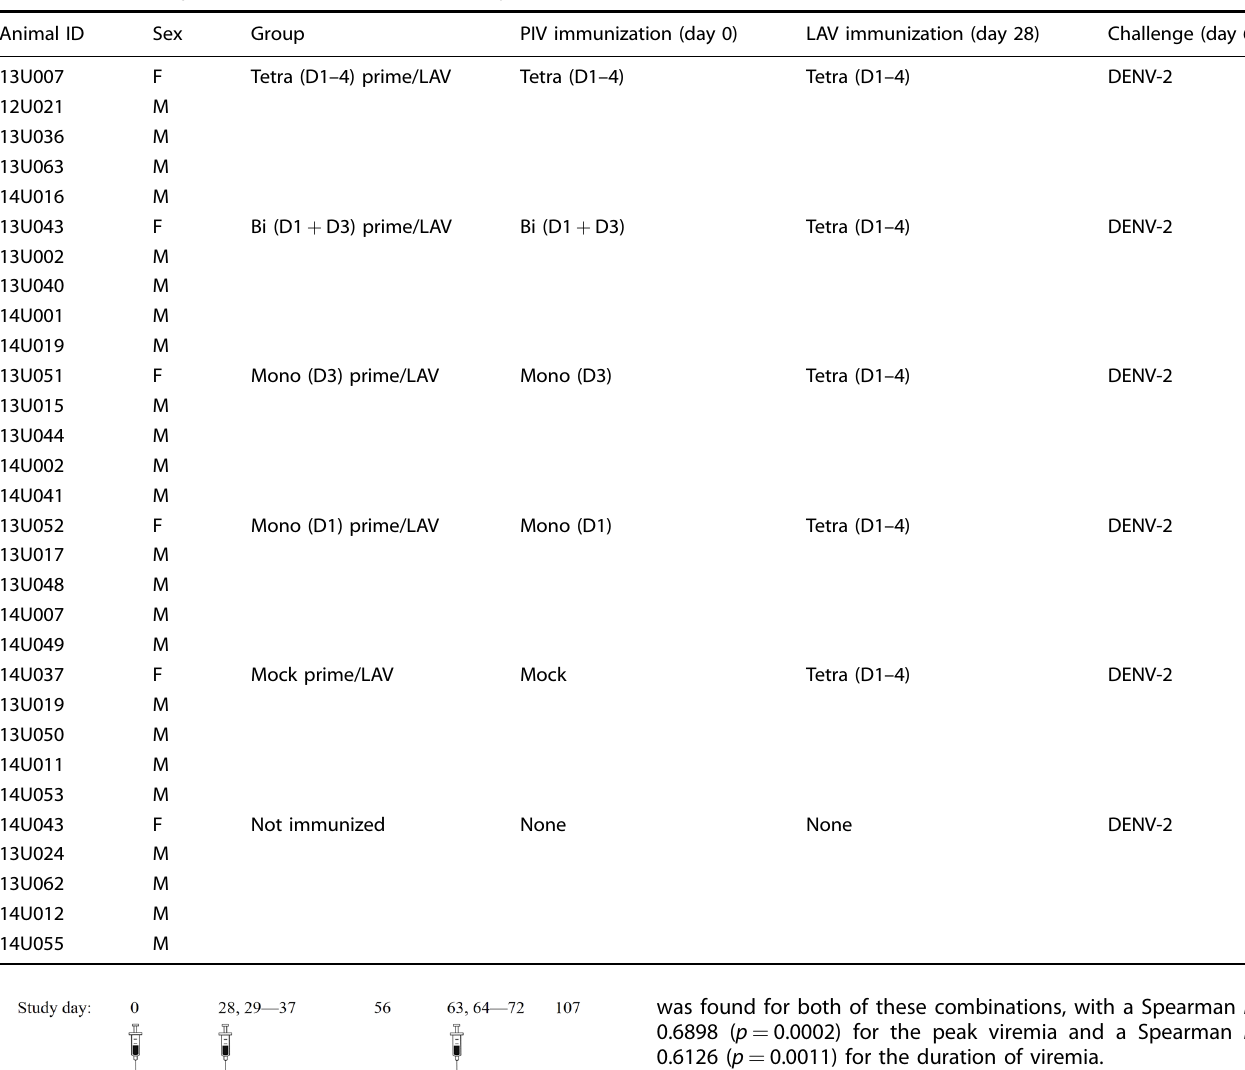
Table 1. Group designation and immunization scheme by an animal.